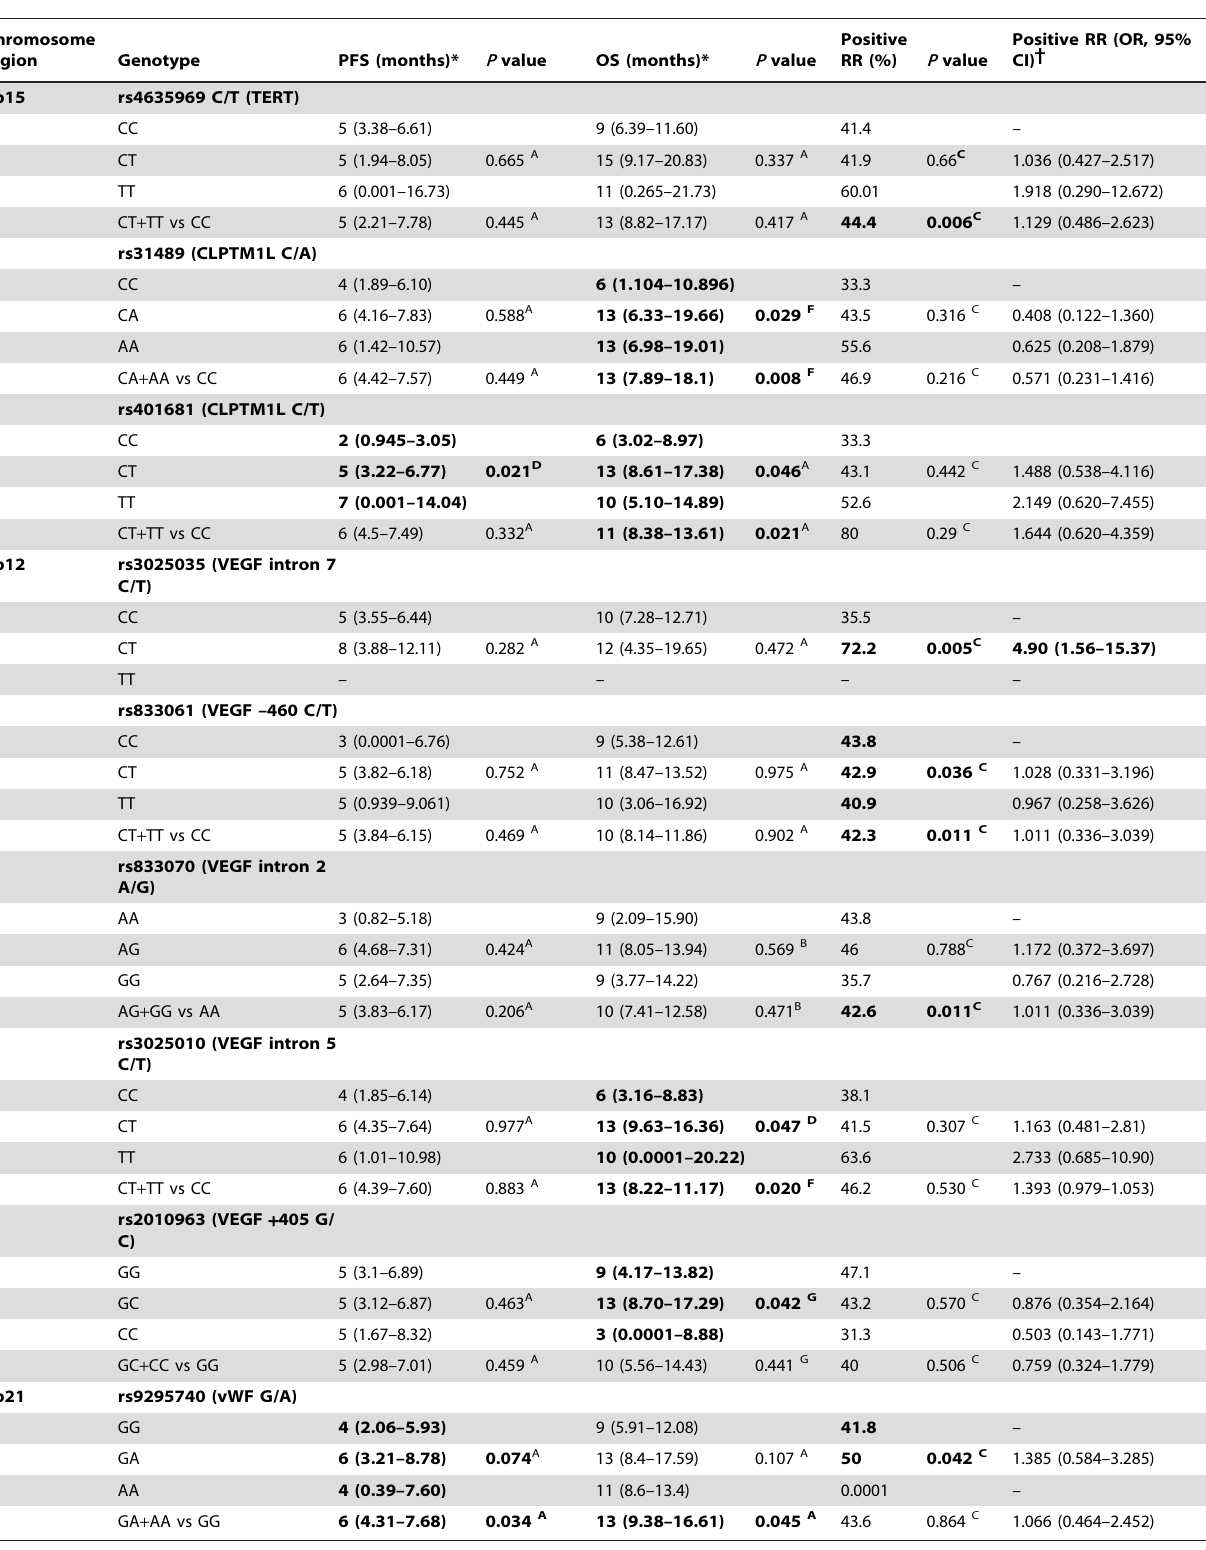
Table 4. Genetic polymorphisms and non-small-cell lung cancer outcome (PFS, OS, RR for 1th line regimen).